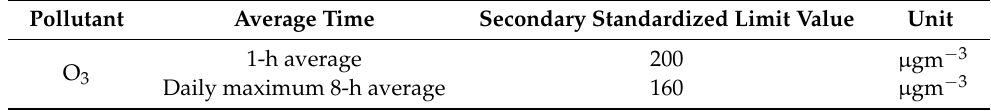
Table 2. Air quality standards used in China (GB